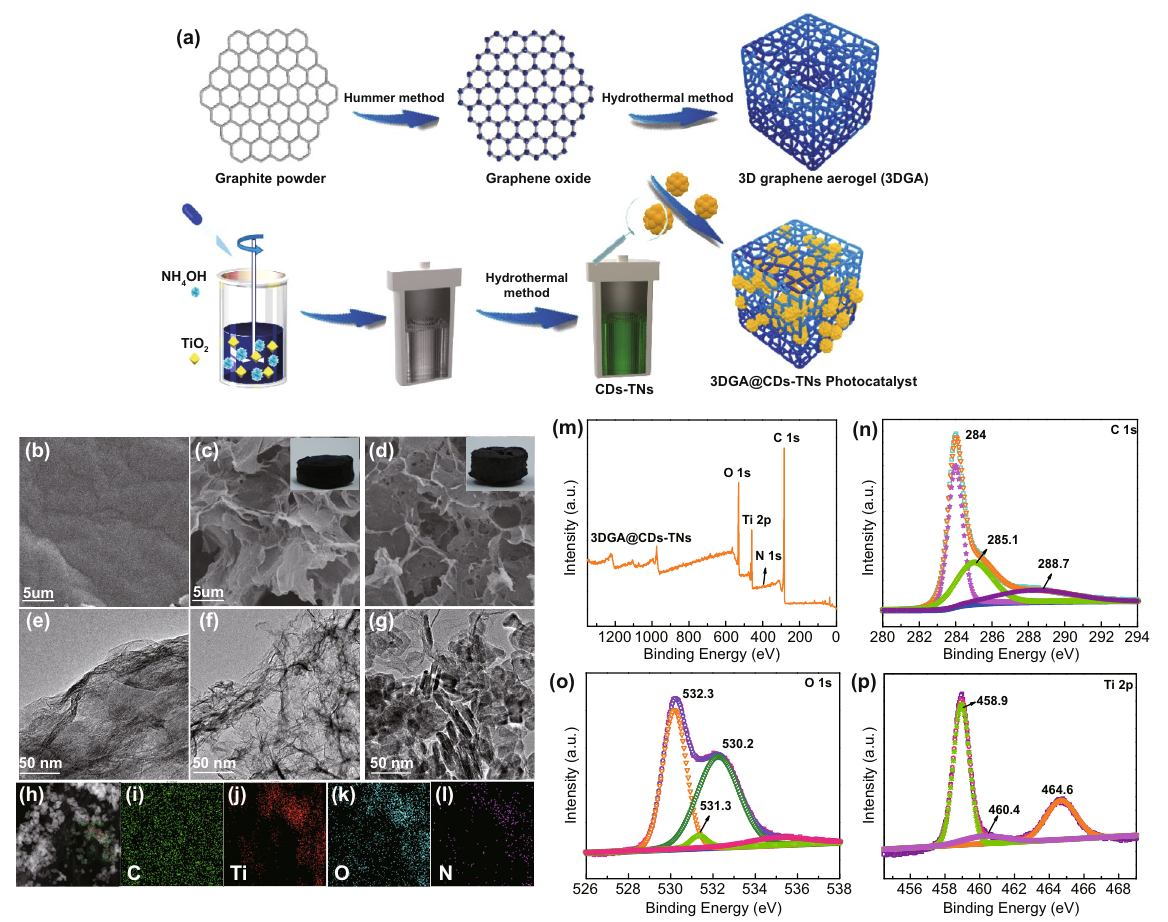
Fig. 2 a Schematic showing the synthesis of 3DGA@CDs-TNs photocatalyst. SEM images of b GO, c 3DGA inset: the picture of 3DGA; and d 3DGA@CDs-TNs, inset: the picture of 3DGA@CDs-TNs. TEM image of e GO, f 3DGA, and 3DGA@CDs-TNs g , and corresponding